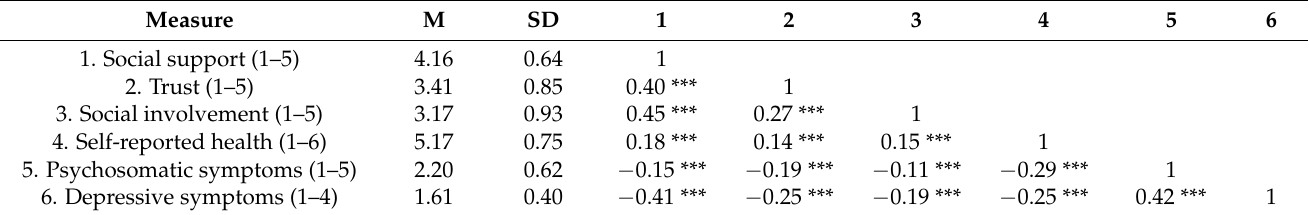
Table 2. Descriptive statistics and zero-order correlations for all study